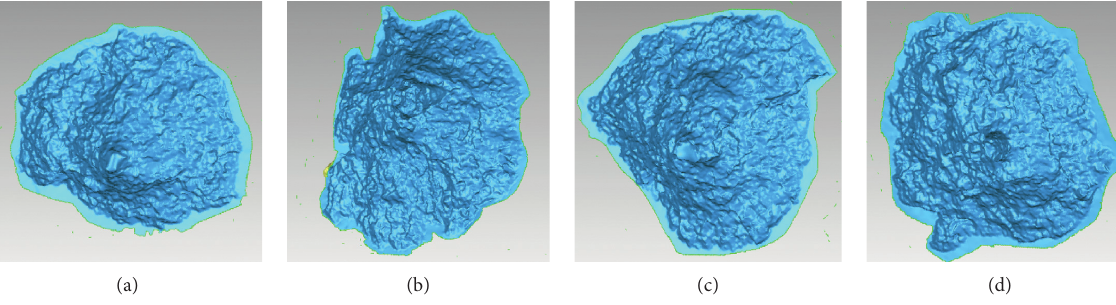
Figure 11: 3D scan of the damaged area. (a) Target 2, (b) target 5, (c) target 9, and (d) target